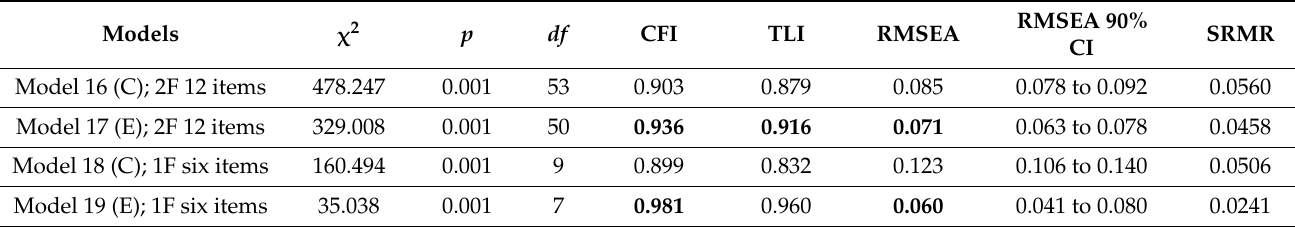
Figure 2. Models representing the 12-item IAT ( a ) and the six-item IAT ( b ) among university students. Table 6. Goodness-of-fit indices for models representing the 12-item Internet Addiction Test (12-item IAT) and the six-item IAT in confirmatory factor